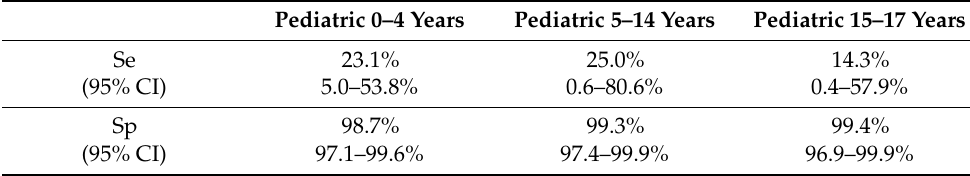
Table A3. Sensitivity and specificity of the RAT in different pediatric age groups.